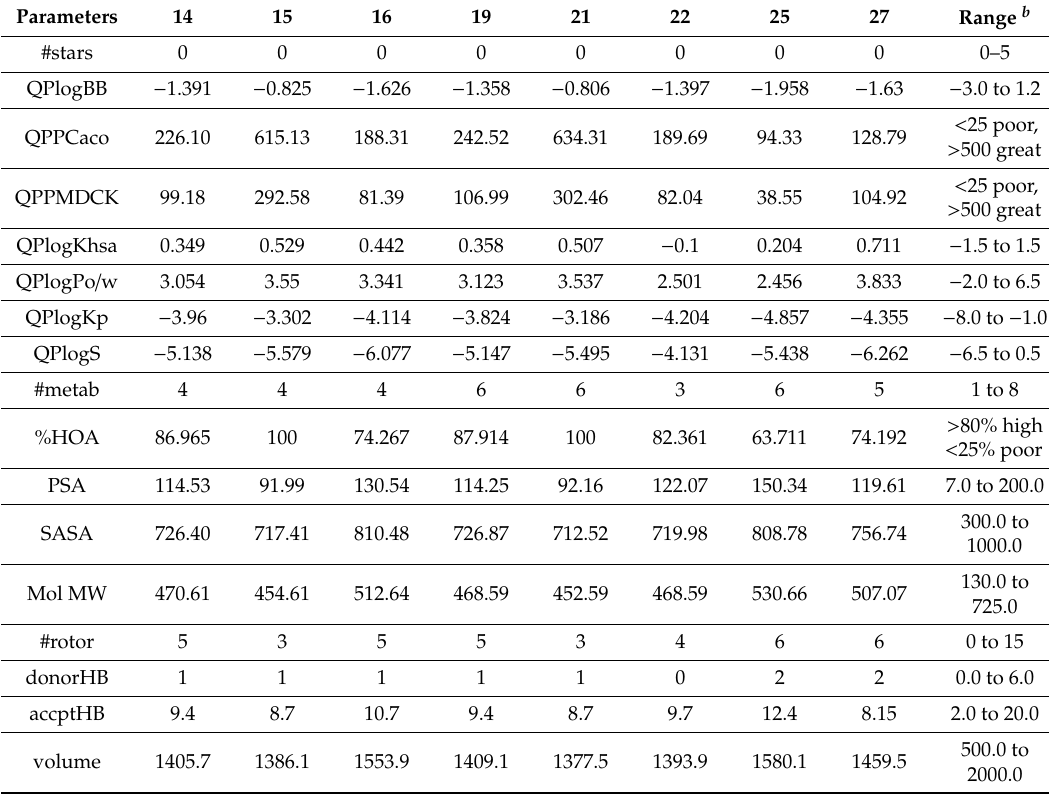
Table 4. In silico ADME profile prediction of selected withanolides a and their range / recommended values b